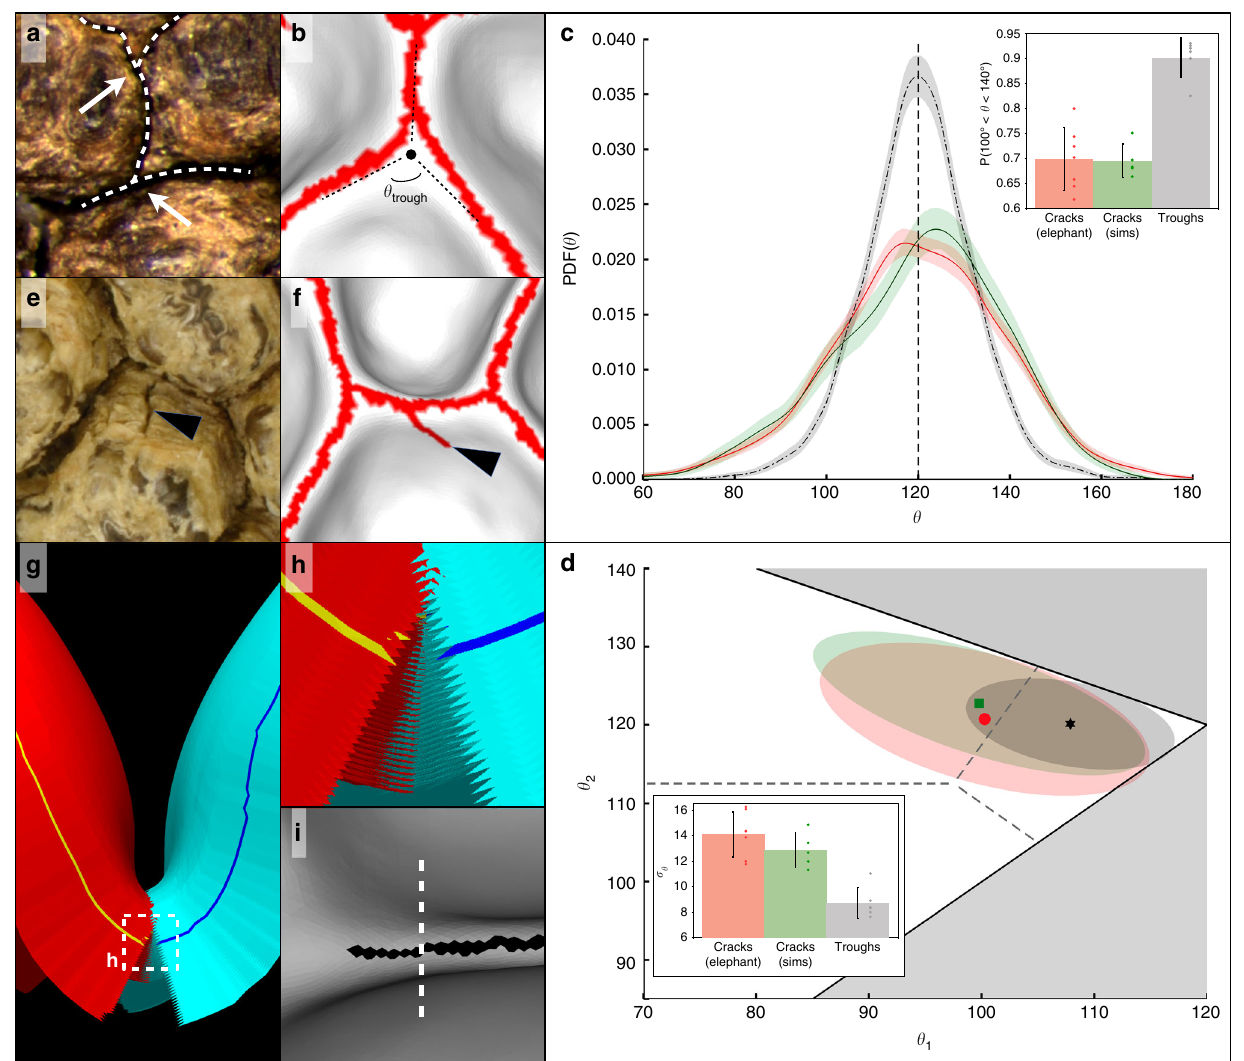
Fig. 5 The physical model captures qualitative and quantitative features of the cracked skin pattern. a , b Crack junctions on the elephant skin (arrows in a ) and in simulations ( b ) typically display an angular pro fi le with a small (<90°) and two large (>135°) angles. Propagating cracks tend to avoid the centre of trough junctions (black dot in b ) because of the heterogeneous strain distribution at the intersection (Supplementary Fig. 9). c There is a good fi t between the probability density functions (PDFs) of the angular distribution of real skin (red line, N = 2997) and simulated (green line, N = 966) cracks, whereas they differ markedly from that of trough angles (black line, N = 3645). Shaded regions represent 95% con fi dence intervals. Inset: probability of fi nding an angle between 100° and 140°; mean (error bars = s.d.) among 7 PDFs of observed cracks (red, Supplementary Tables 3 and 4), 5 PDFs of simulated cracks (green, average of 193 angles per PDF) and 6 PDFs of observed troughs (grey, Supplementary Tables 2 and 4). d Angular scatter plot (shaded regions represent 50% con fi dence regions, see Methods) showing the 2D average and angular spreading of the fi rst two angles of skin crack junctions (red point, N = 999), simulated crack junctions (green square, N = 322) and trough junctions (black star, N = 1215). The similarly oriented and dispersed angular pro fi les of skin and simulated crack junctions contrast with the ‘ triple-120° ’ trough pro fi le. Inset: angular spreadings of crack and trough junctions; mean (error bars = s.d.) among 7 angular scatter plots of observed cracks (red, Supplementary Tables 3 and 4), 5 plots of simulated cracks (green, average of 64 vertices per plot) and 6 plots of observed troughs (grey, Supplementary Tables 2 and 4). e , f Rare cases of cracks propagating outside the troughs (arrowheads) in elephant ’ s skin ( e ) and simulations ( f ). g , h Our physical model reproduces in silico the observed sheet alignment; yellow and dark blue lines represent the simulation surface, while the remaining sheets (red and light blue) form the thickness of the stratum corneum . The innermost uncracked sheets of stratum corneum are accounted for in the simulations (see supplementary text). i Top view of a crack (the dashed line indicates where the ‘ virtual section ’ ( g , h ) was